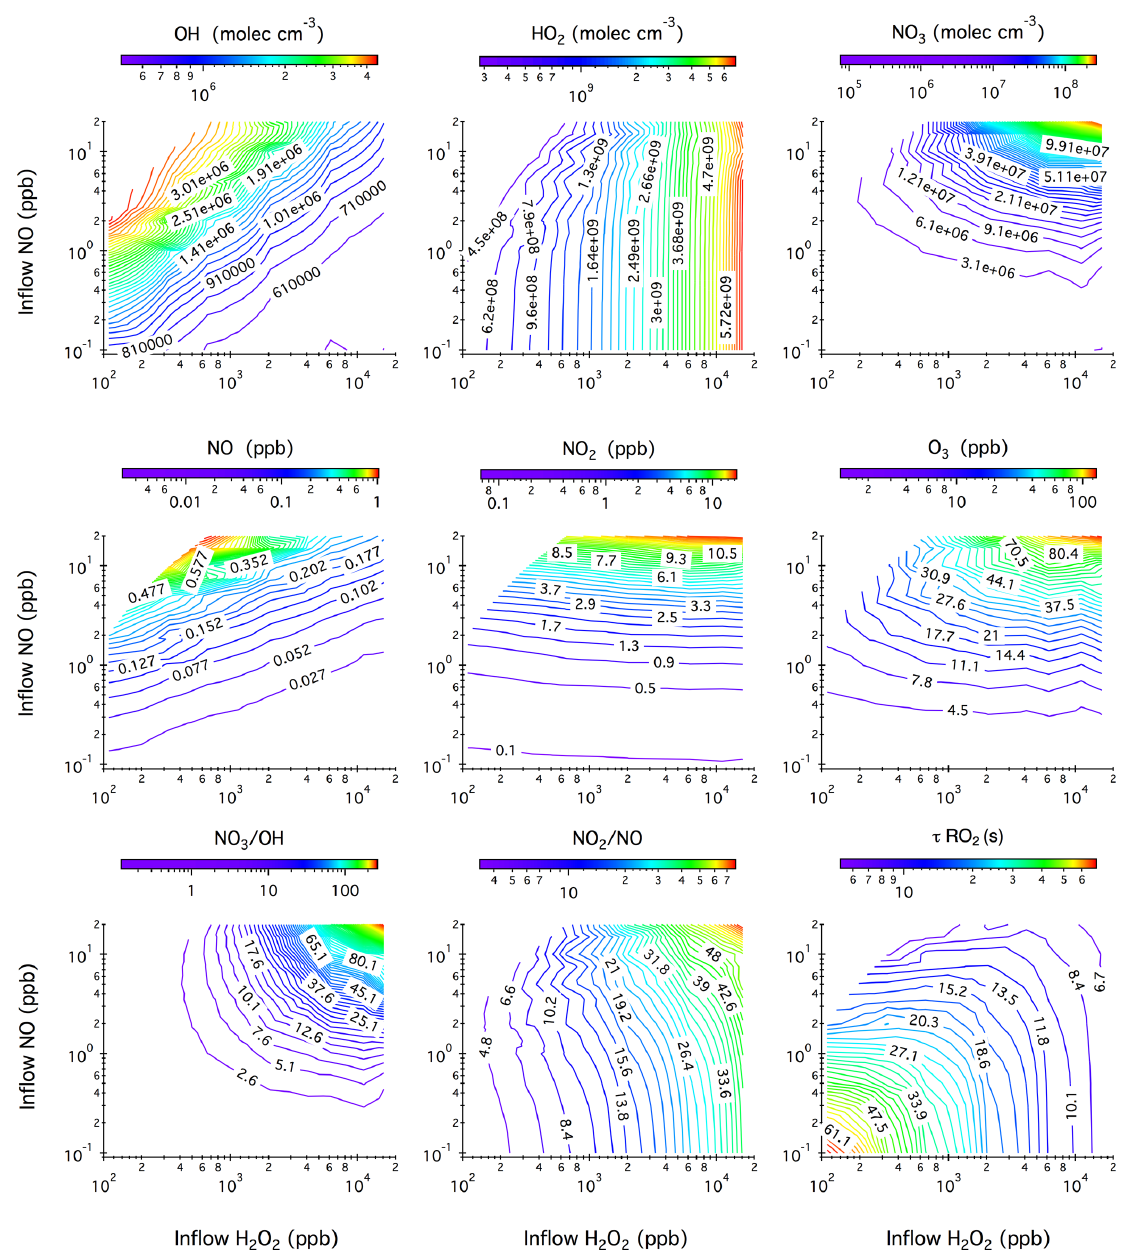
Figure 1. Contour plots showing the model-predicted steady-state mixing ratios of OH, HO 2 , NO 3 , NO, NO 2 , and O 3 after 20h of photo- chemical reactions in the chamber as a function of the concentrations of H 2 O 2 and NO in the continuous injection flow. Also given here are the simulated NO 3 to OH ratio, NO 2 to NO ratio, and the lifetime of an RO 2 radical ( τ RO Note that the ripples on the contour lines originate from the limited simulation datasets that are used to generate iso-response